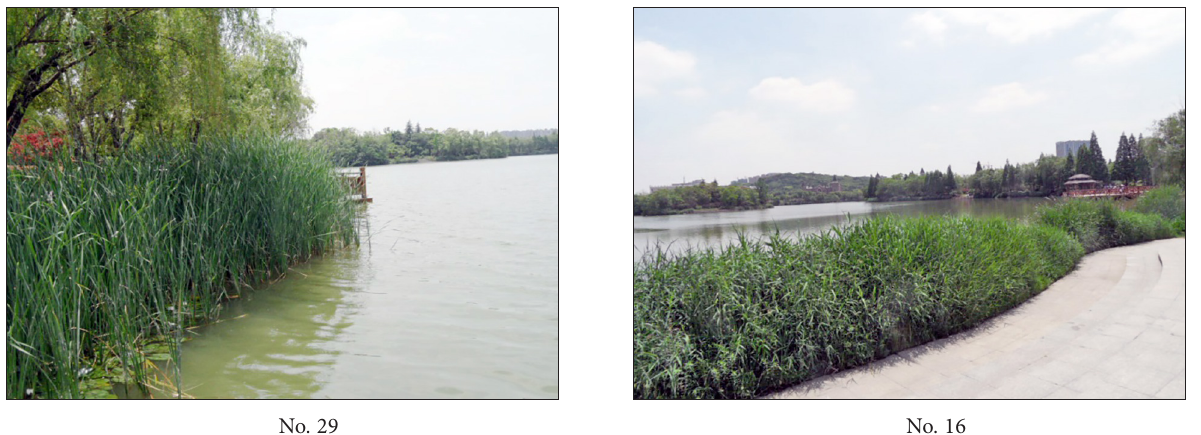
Figure 4. Photos with lower principal factor comprehensive evaluation value of plant